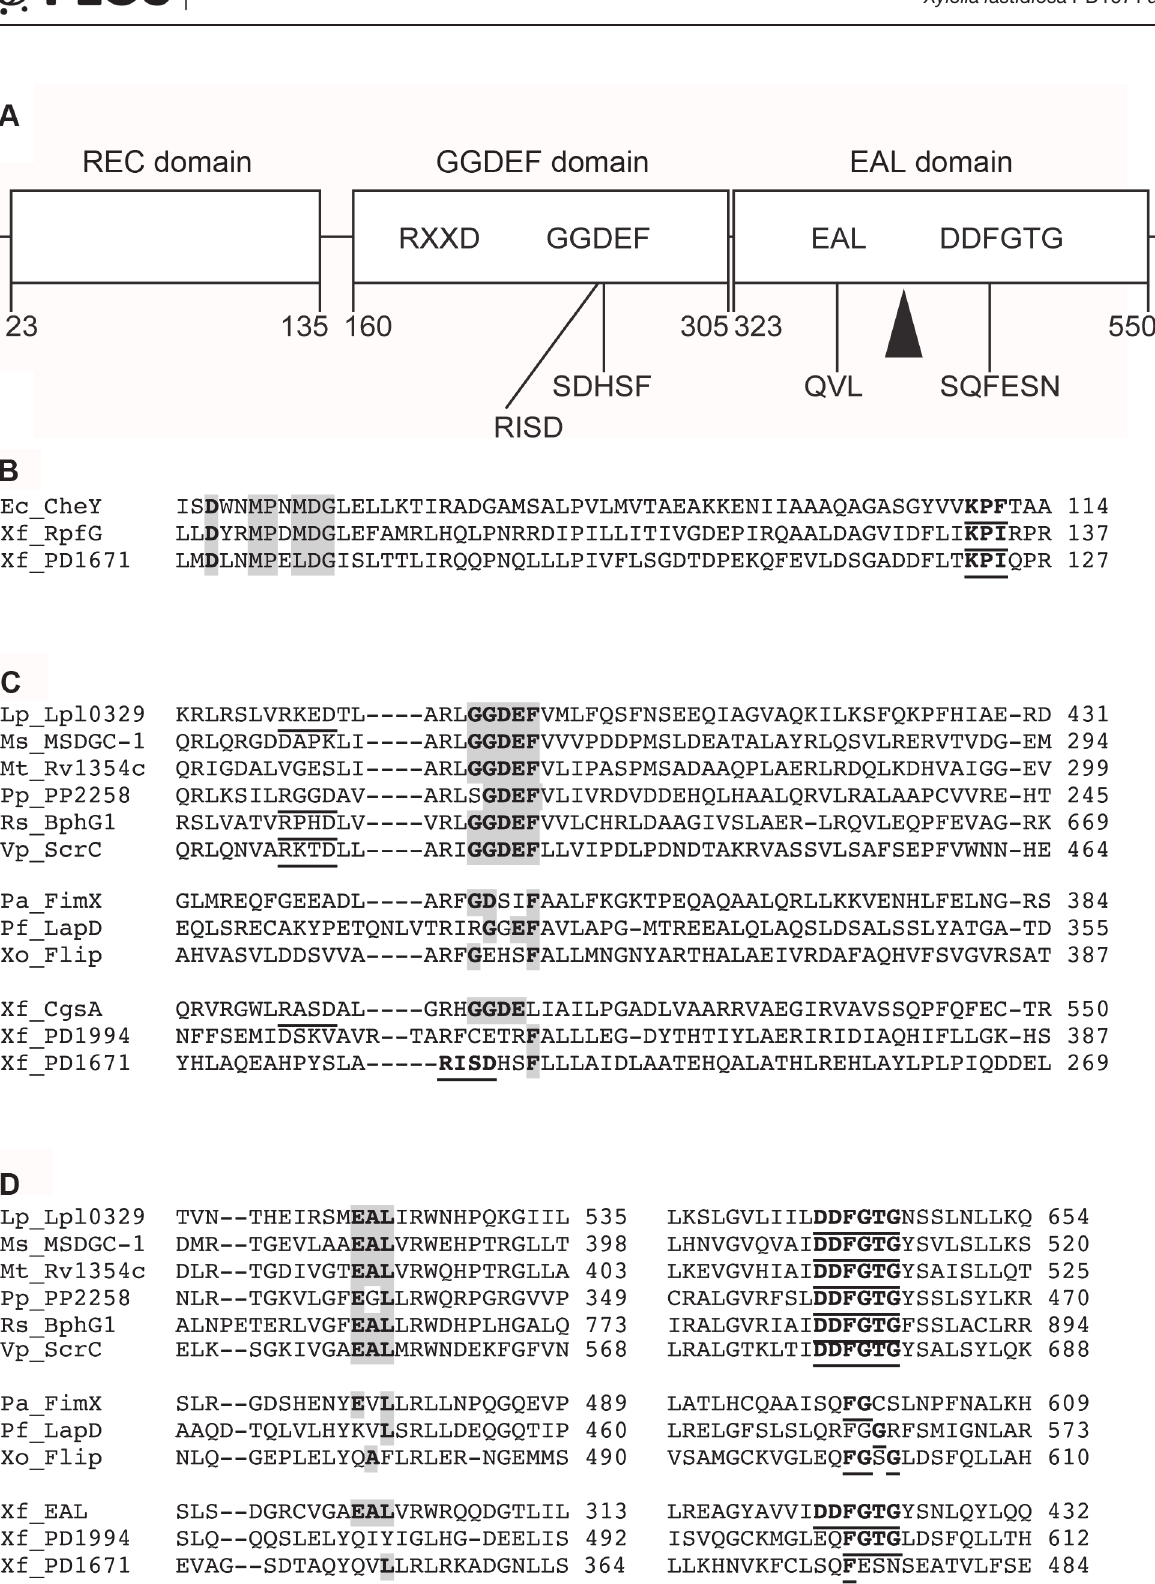
Fig 1. Putative PD1671 domains. A ) Boxes represent the three PD1671 domains with domain names above the boxes and amino acid numbers below the boxes. Bacterial diguanylate cyclase and phosphodiesterase consensus sequences listed in boxes (X is any amino acid), and PD1671 aligned sequences listed below the boxes at their approximate locations. Arrow head denotes Tn5 insertion point. B ) REC domain alignment. Xylella fastidiosa PD1671